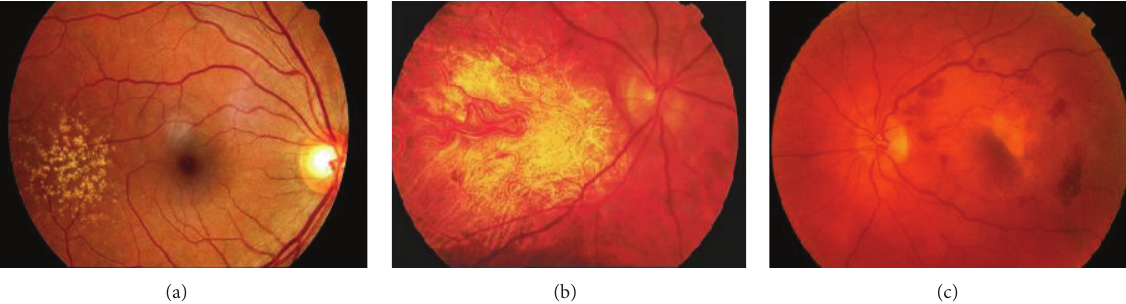
Figure 1: Hard drusen at the temporal side of macula in patient with dry ARMD (a), geographic atrophy (b), and CNV in patient with wet ARMD